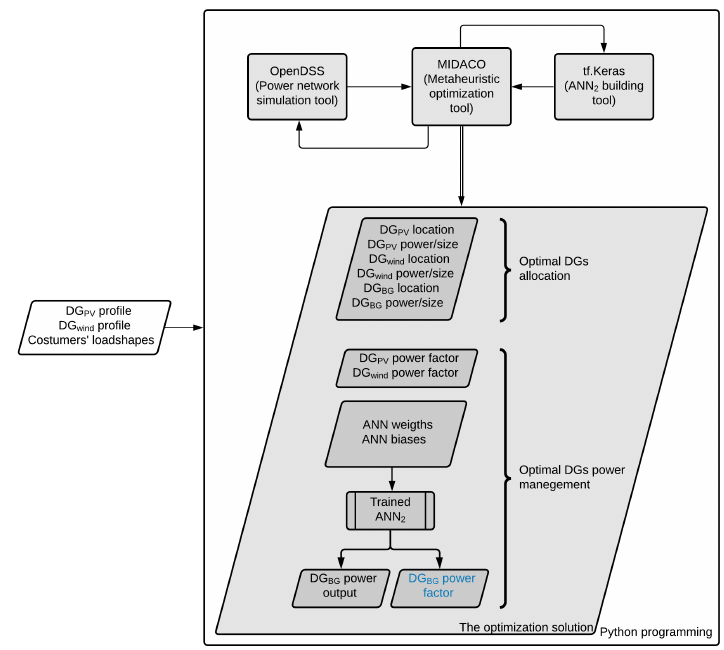
Figure 2. The framework used for Opt 2 optimization